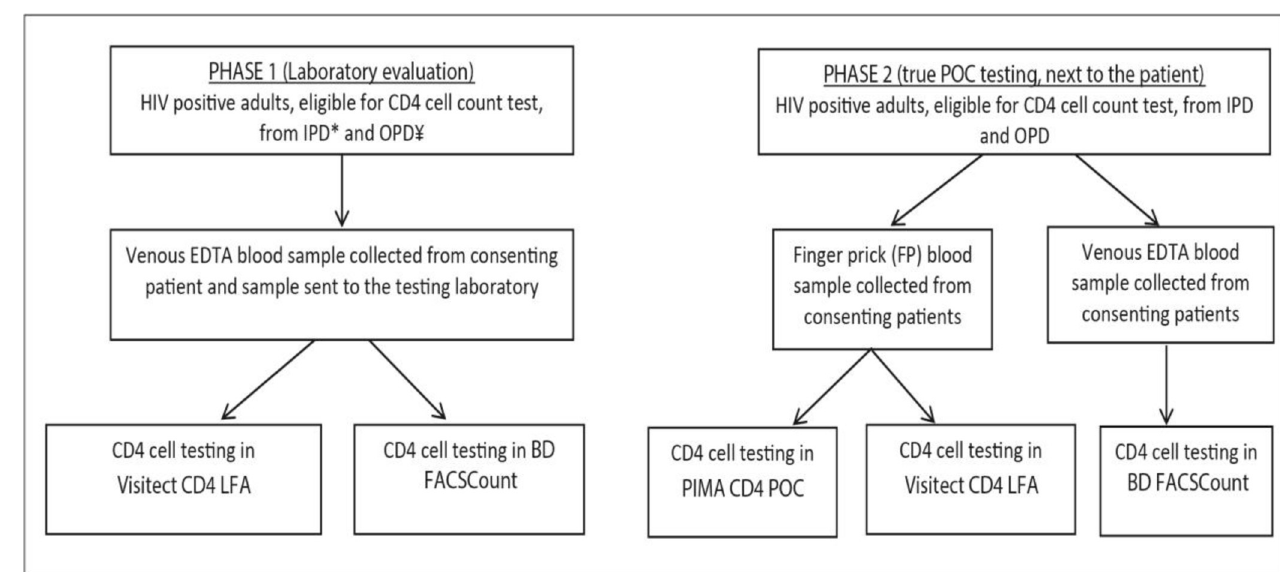
Fig 1. Study sample collection and testing flow. Key: � IPD-in-patient department, ¥OPD-out patient department.